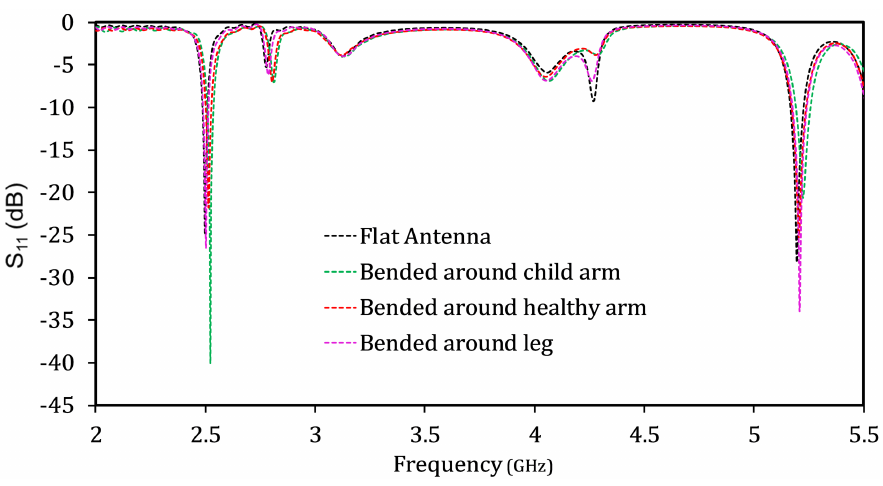
Figure 17. Off-body reflection coefficient of the conventional dual band antenna.